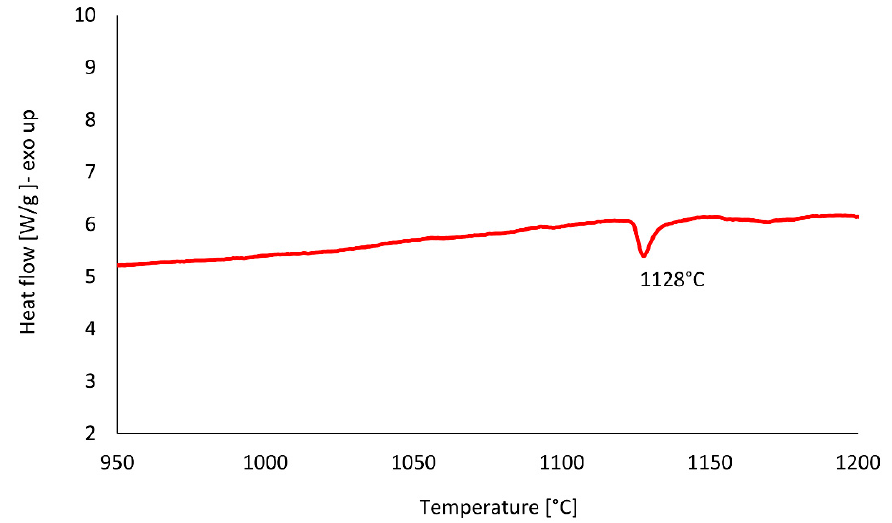
Table 2. The volume fraction of NiTi 2 /Ni 2 Ti 4 O phases in HT1-HT3 samples.